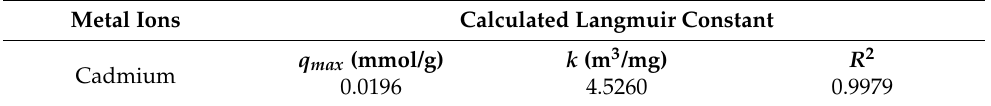
Table 1. Summary on the adsorption isotherm.